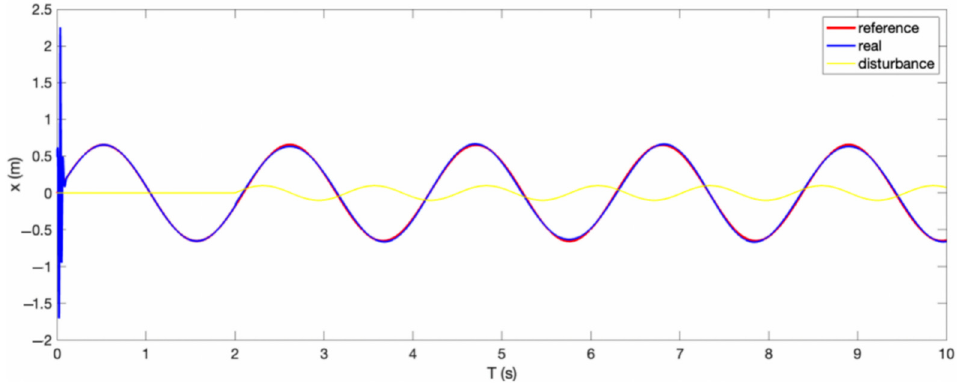
Figure 21. The reference trajectory (red cure) and the system response (blue curve) of the footrest posture control with RBFNN approximation with disturbance (yellow curve).